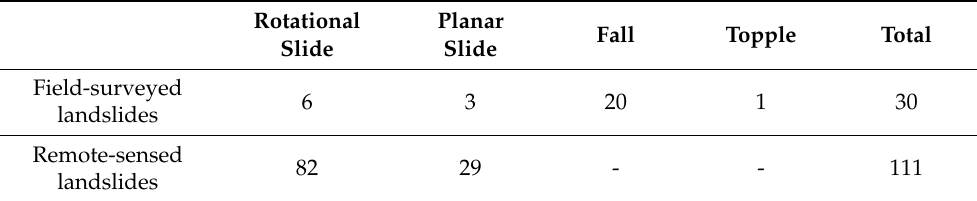
Figure 7. Mapped landslides surrounding the Pan-American infrastructure that can potentially involve it: in this figure, mass movements detected both through field surveys and with the application of KDE algorithm to SAR data are reported. In the bottom right corner, the types of movements of detected landslides are summarized. Table 2. Methods of detection for the landslides in the buffer zone surrounding the Pan-American